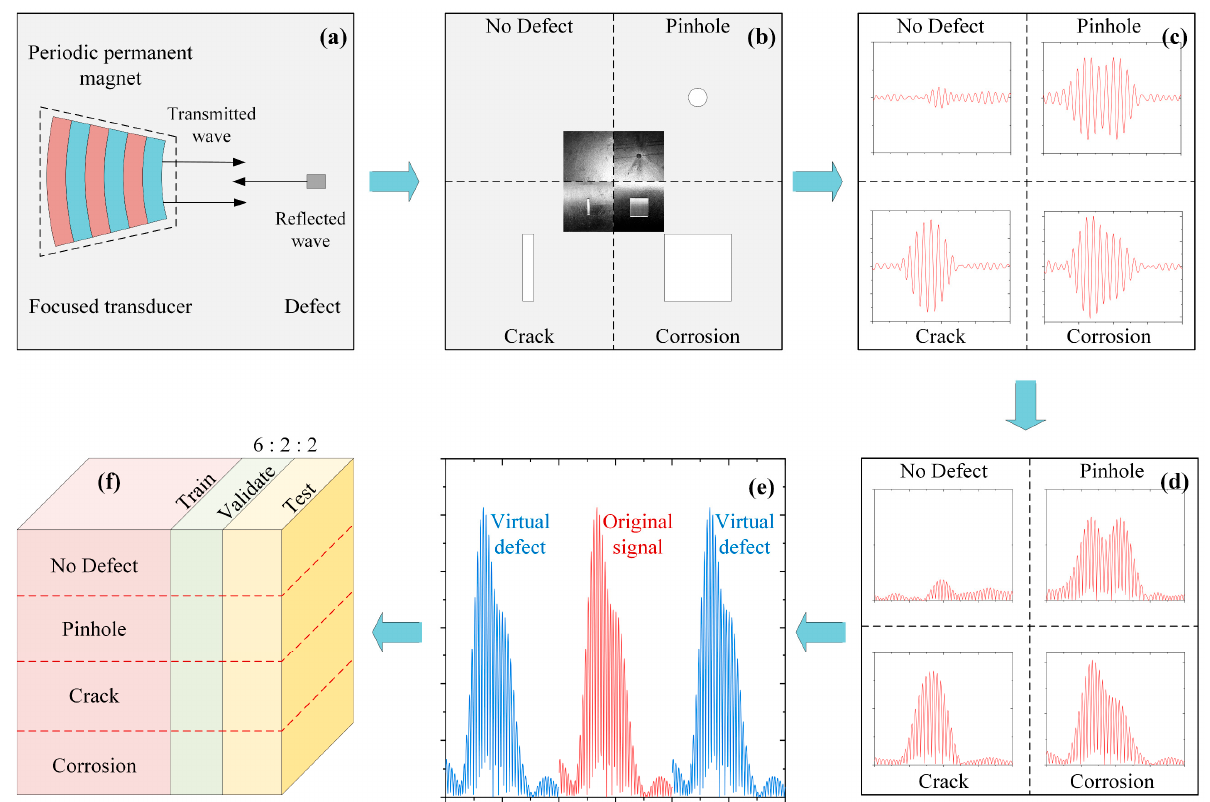
Figure 1. Dataset collection: ( a ) EMAT structure and defect detection method; ( b ) three different types of artificial defects considered, i.e., pinhole, crack, and corrosion and the nondestructive specimen in pipes; ( c ) detection signals for different defect types; ( d ) standardized results using absolute value normalization to limit the data range and minimum value suppression to remove unreasonably small data; ( e ) virtual defect method for data enhancement; ( f ) composition of the ultrasonic guided wave detection signal dataset, where the ratio of the training, validation, and test datasets is 6:2:2.